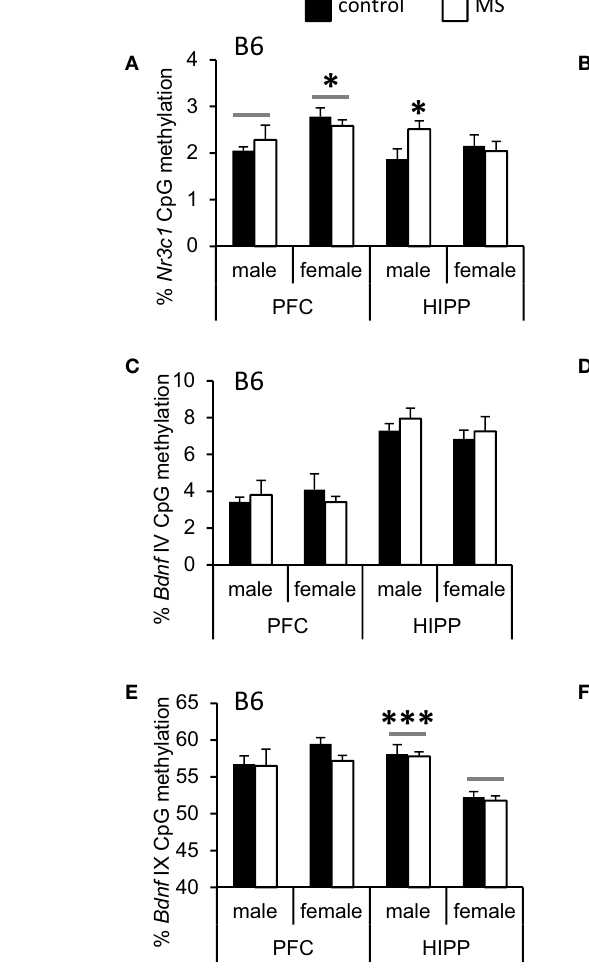
FIGURE 5 |Average percent DNA methylation of the Nr3c1 and Bdnf promoter regions in the cortex (PFC) and hippocampus (HIPP) . (A) Increased Nr3c1 DNA methylation was observed in the HIPP of MS-reared B6 males and (B) no MS-rearing effects on DNA methylation of this gene in Balb/c mice. In the PFC, sex differences (indicated by a gray bar) were present in both B6 and Balb/c mice (elevated Nr3c1 DNA methylation in females compared to males). In the hippocampus, Balb/c females had reduced Nr3c1